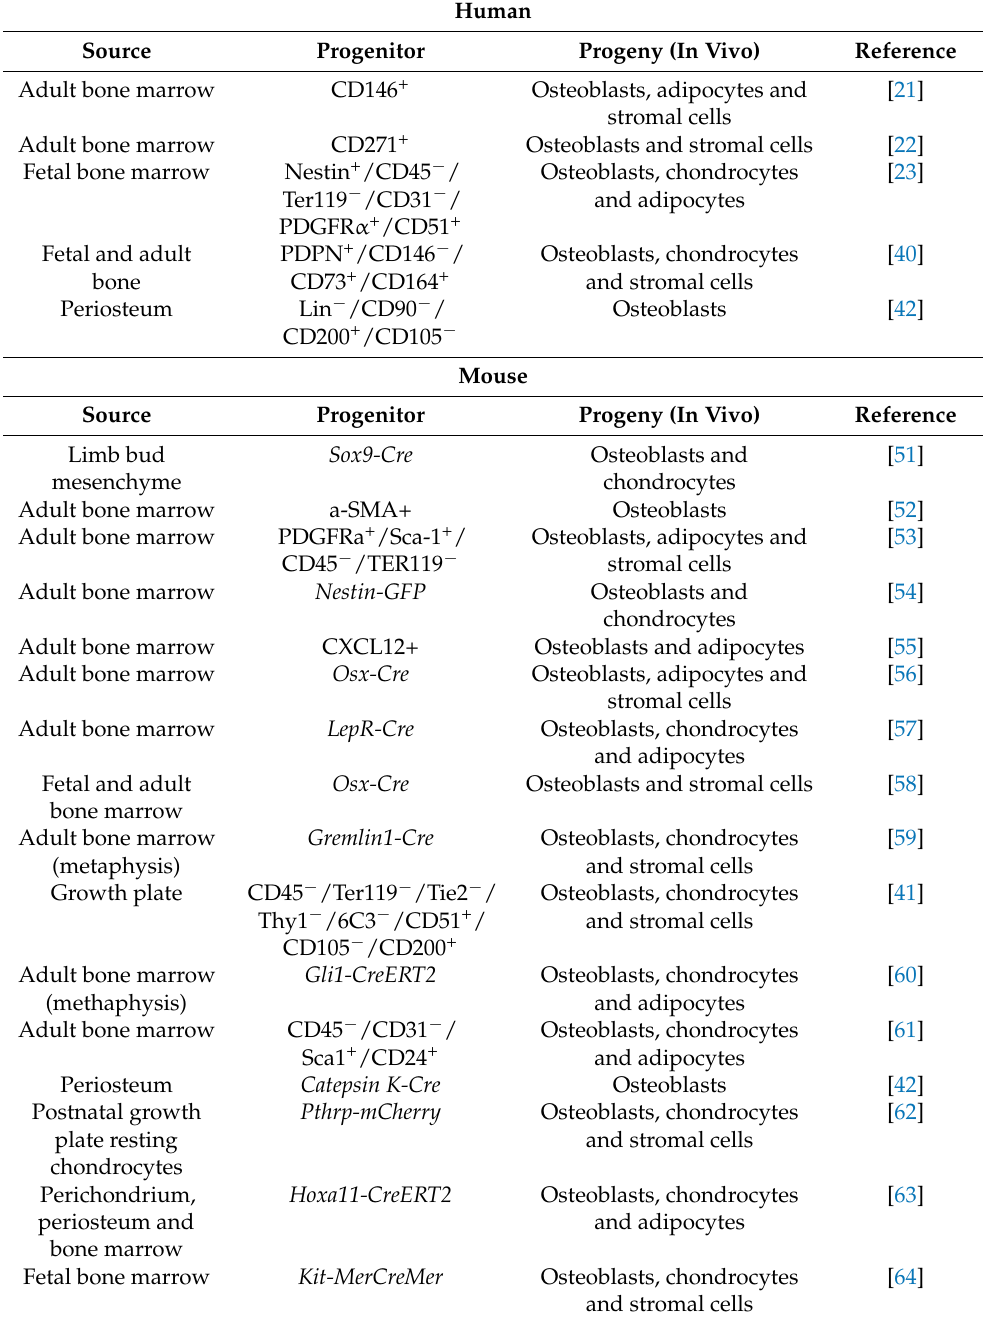
Table 1. Human and mouse osteoprogenitor cell